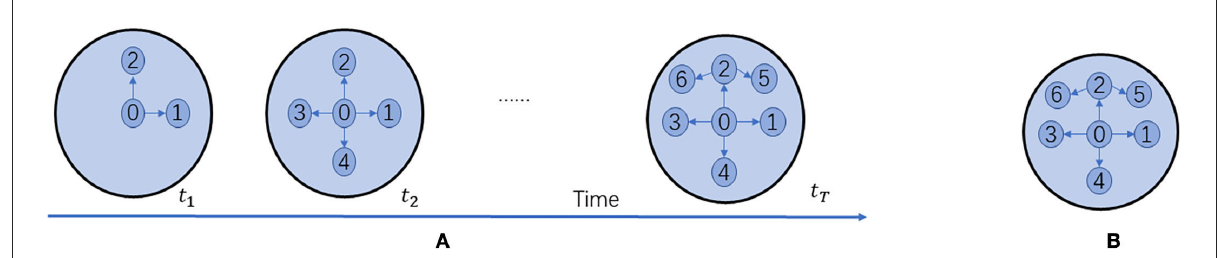
FIGURE1 Subfigure (A) illustrates how to model the propagation of news using a dynamic graph structure, whereas subfigure (B) illustrates how to model the propagation of news using a static graph structure, where nodes signify tweets or retweets and edges denote retweets or comments. (A) Dynamic graph; (B) Static